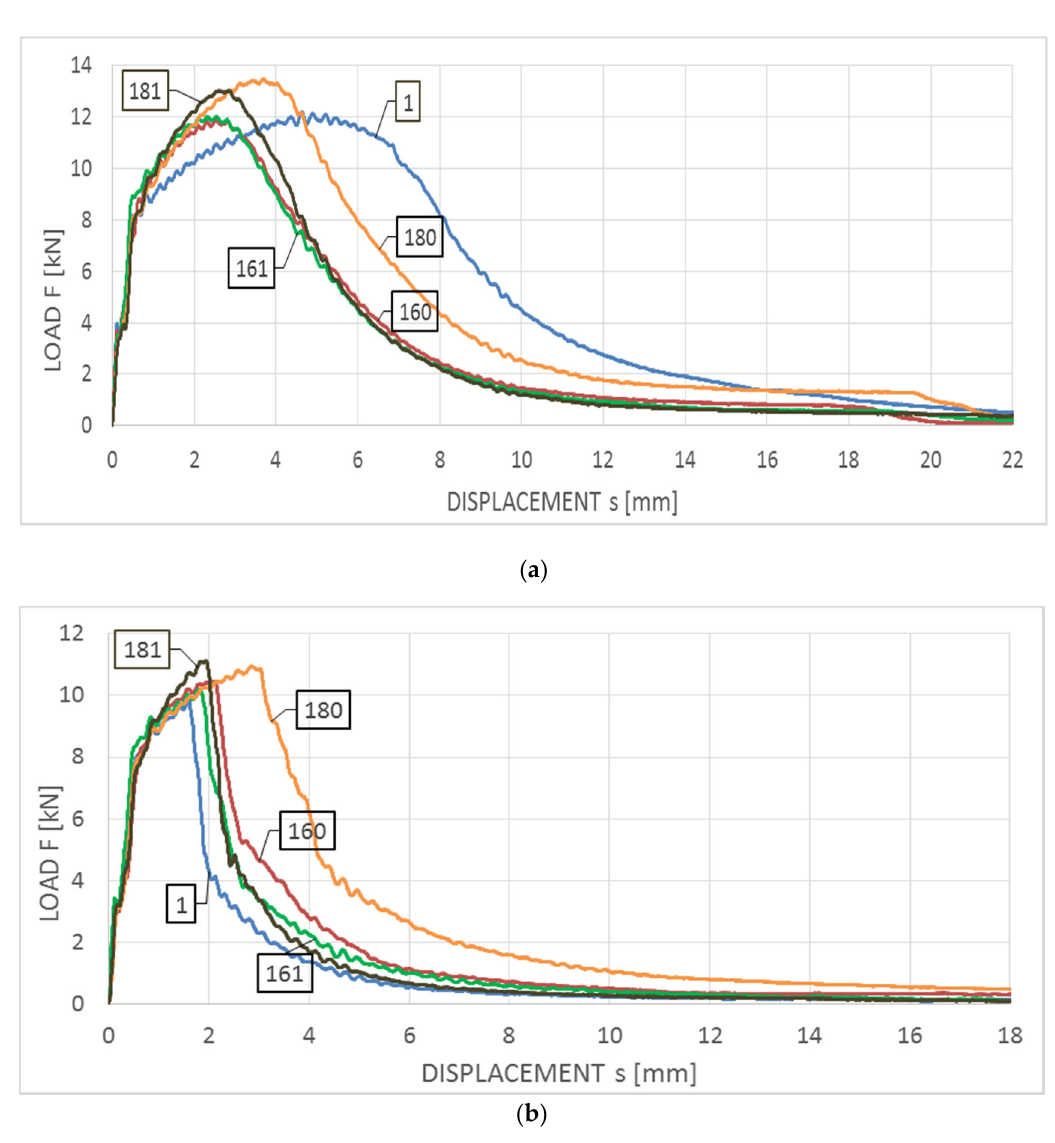
Figure 8. Averaged 𝐹 − 𝑠 curves obtained on samples made of S355J2+N steel: ( a ) during tests conducted in +20 °C, ( b ) during tests conducted in − 20 °C.